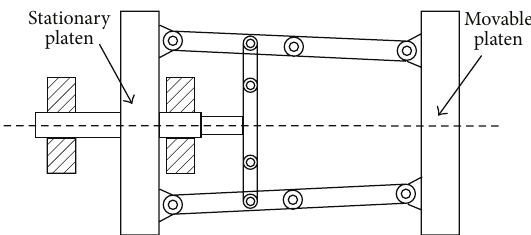
Figure 1: The schematic plot of double-toggle clamping